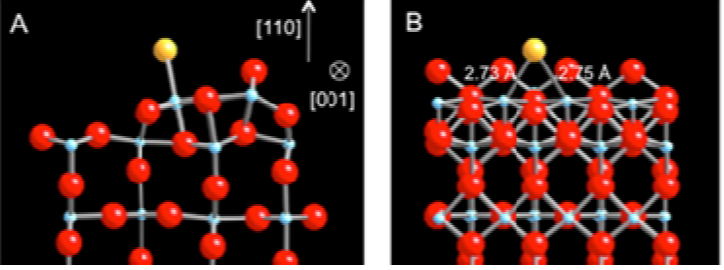
Figure 2. DFT-relaxed structure of Au adsorbed on the sub-stoichiometric strand defect on (110) viewed along ( a ) [001], ( b ) [1–10], and ( c ) [ − 1–10] (Au: yellow, Ti: blue; O: red). TiO 2 ( d ) The charge density difference isosurface plot of (b) revealing electron surplus (blue) and depletion